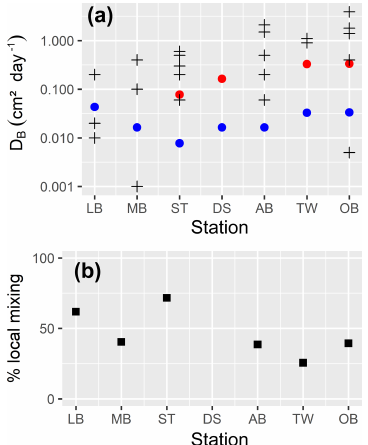
Figure 8. (a) Model estimations of bioturbation intensity (blue dots) manually corrected for sand and silt stations (red dots) and Chl a - based estimates (black crosses); data from Morys et al. (2016). Black crosses represent averages over all cores from a single month when the Chl a profiles in the sediment support the assumption of diffusion–analogue mixing. So, variation can be interpreted as temporal variability. (b) The percentage of the cores at this station whose Chl a profiles could be explained by the assumption of a local diffusion–analogue mixing